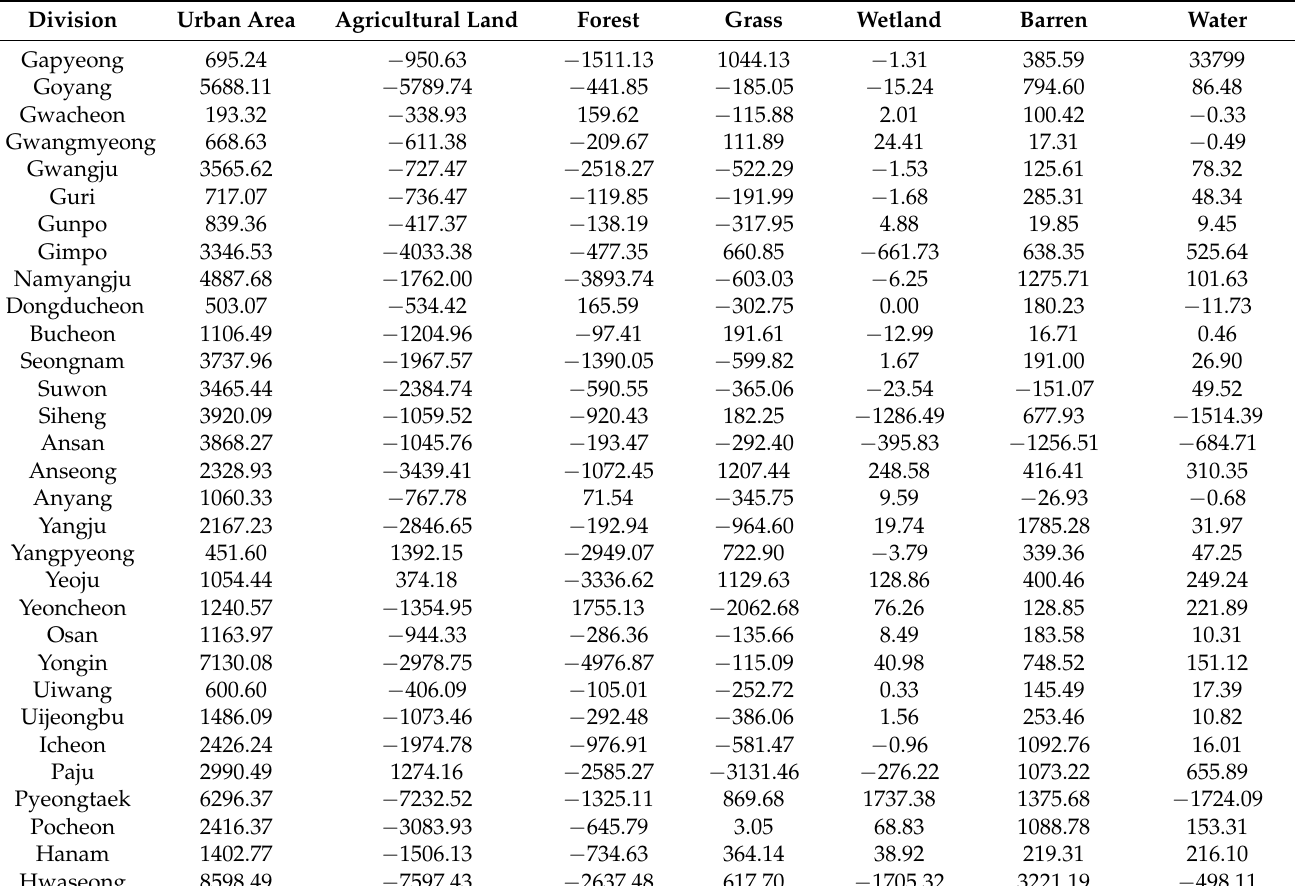
Table 2. Changes in land cover type areas by city (2018–1988) Unit: